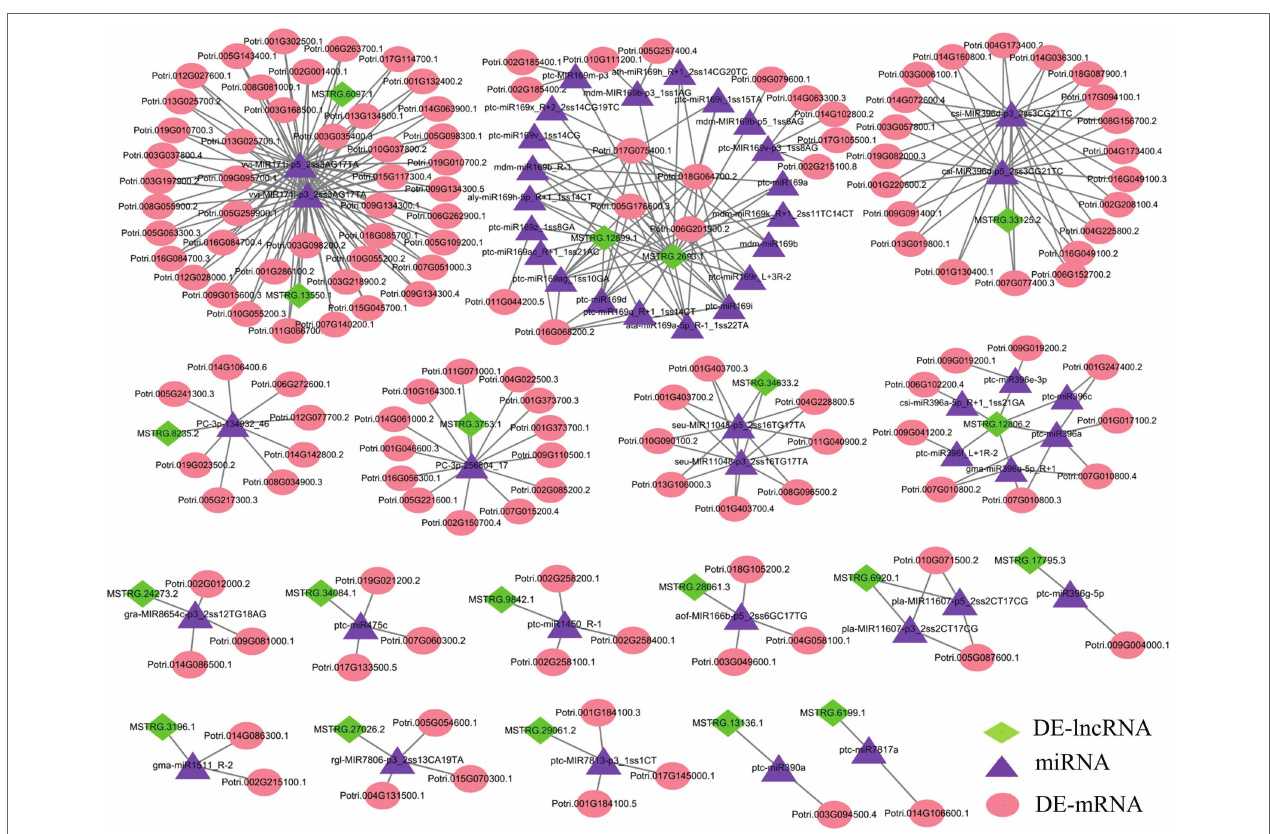
FIGURE 6 | CeRNA networks in P. x canescens roots in response to different nitrogen forms. The green diamond-shaped, purple triangular, and orange round nodes represent DE-lncRNAs, miRNAs, and DE-mRNAs, respectively. Details regarding the abbreviations of the genes are listed in Supplementary Table S10